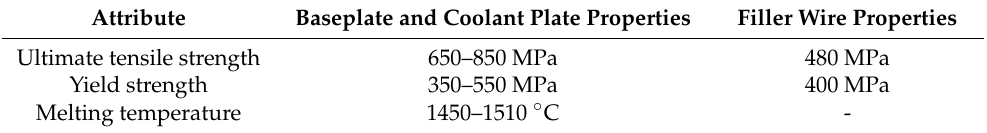
Table 2. EN8 alloy weld plate, coolant plate and filler wire properties.